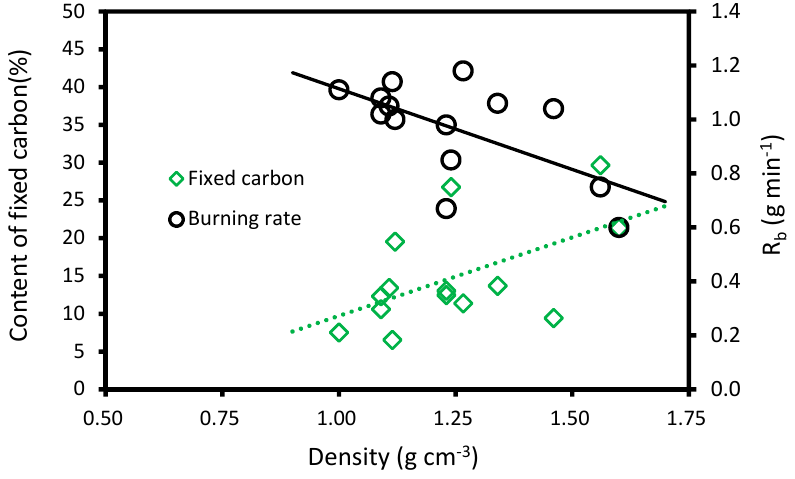
Figure 5. FC ad and R b as functions of density. 232